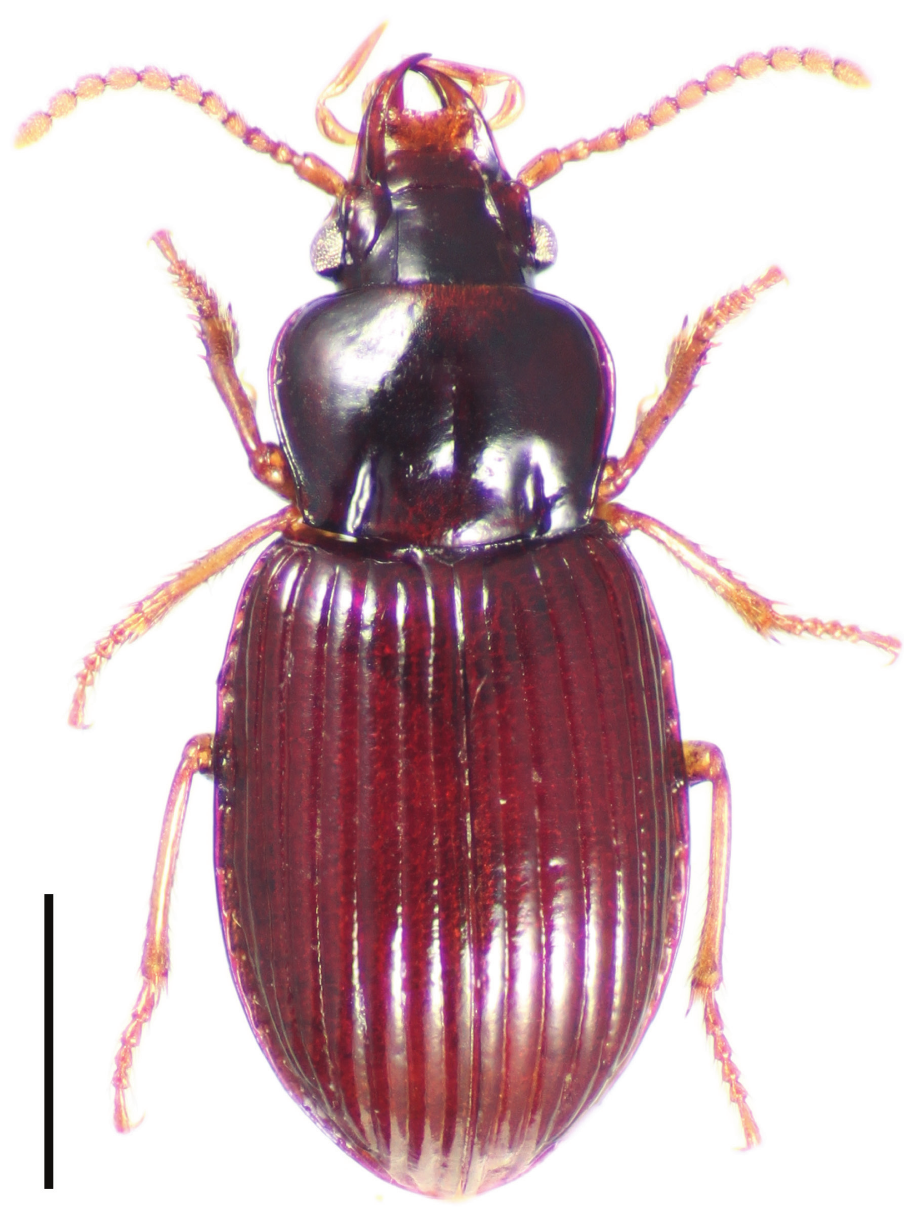
Figure 5. Dorsal habitus image of Cratocerus tanyae Grzymala & Will, sp. n. Scale bar = 1.0